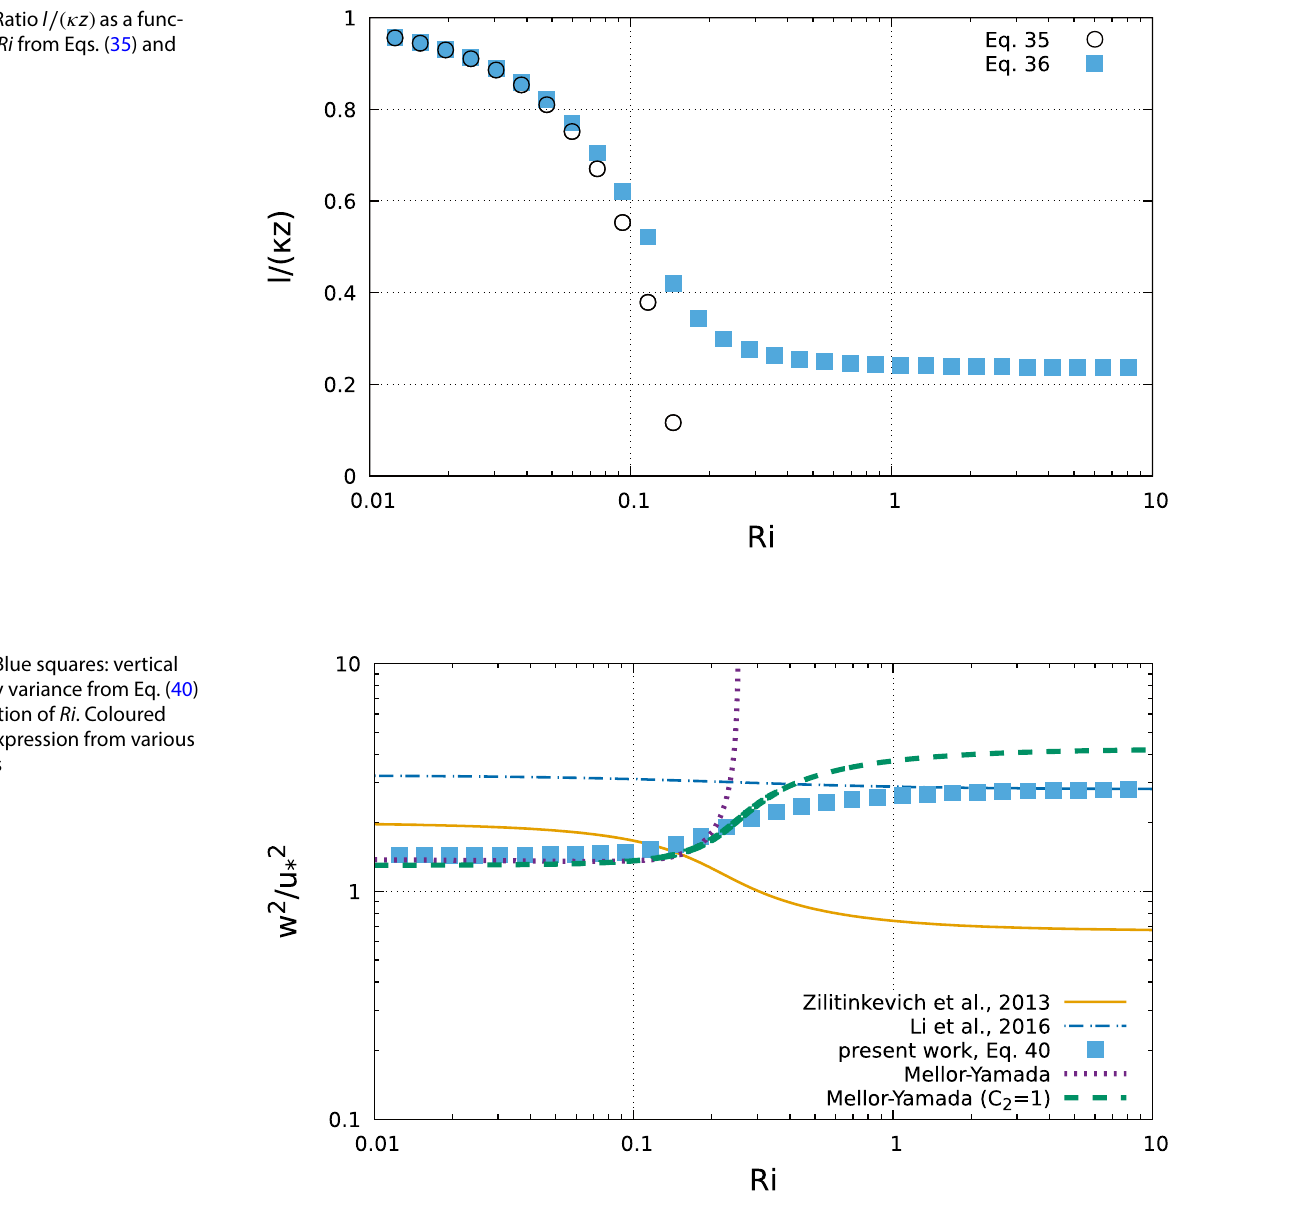
Fig. 3 Ratio l ∕( 𝜅 z ) as a func- tion of Ri from Eqs. (35) and (36)